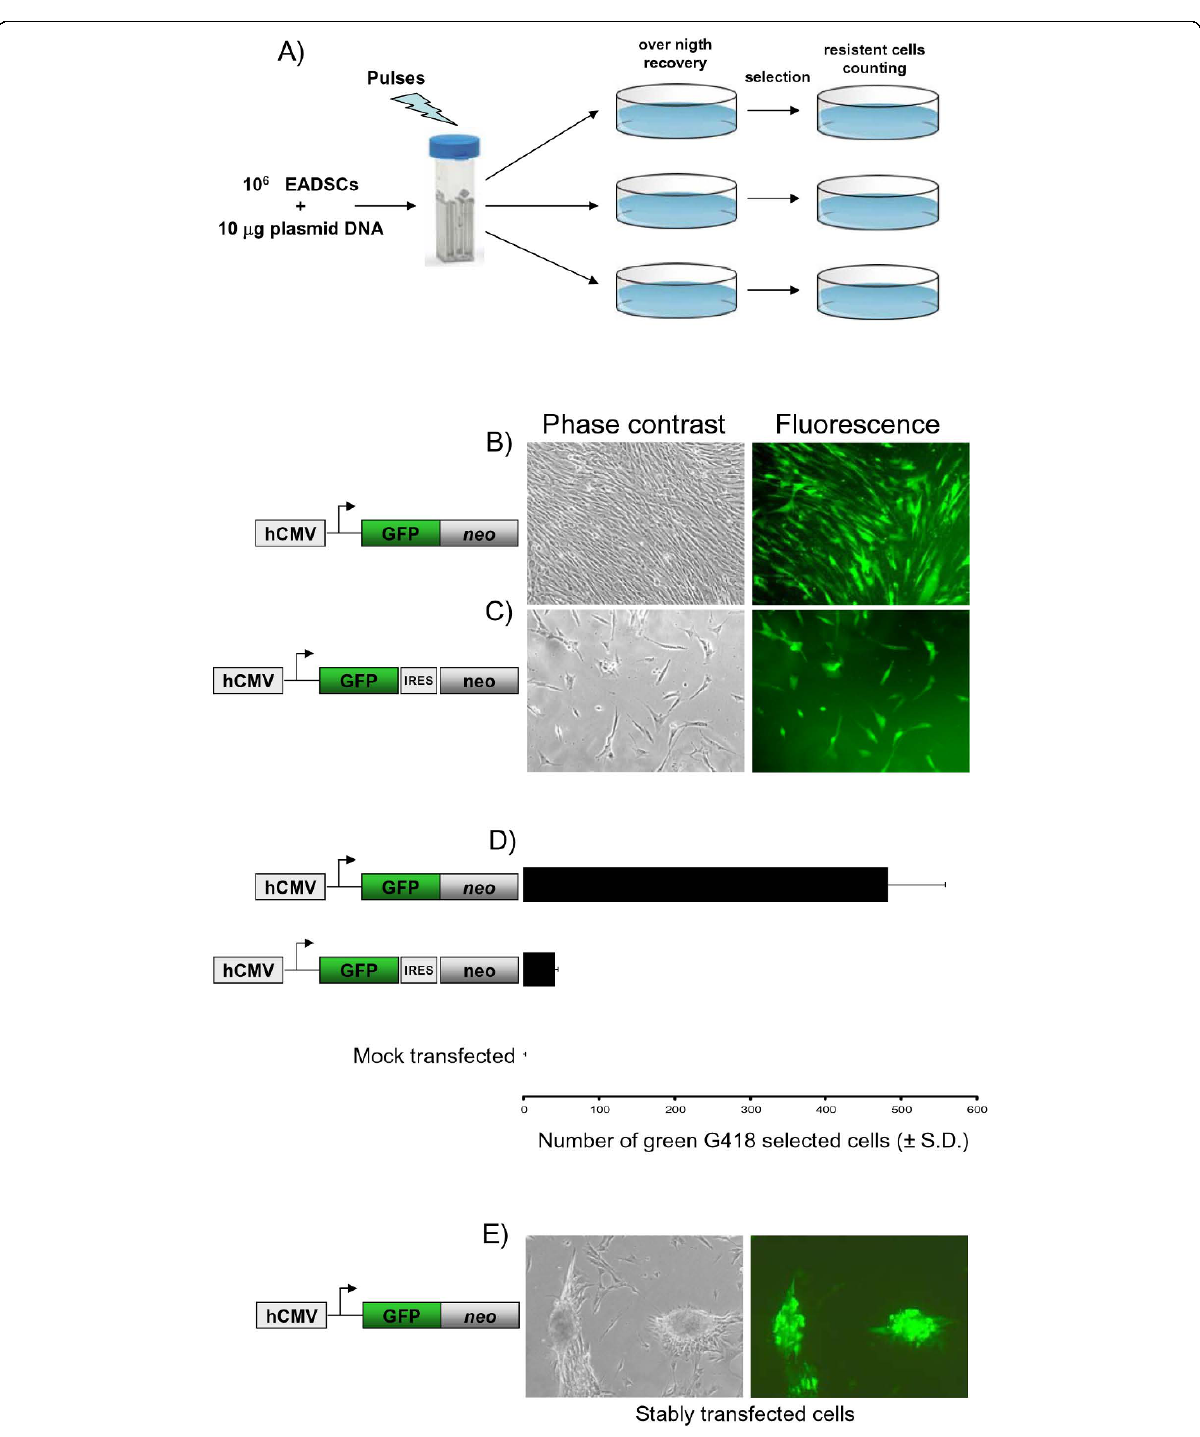
Figure 5 Generation of stably transfected EADSCs . A) Flow chart of the method used to obtain a homogeneous population of EGFP stably labelled EADSCs by electroporation and drug selection. Phase contrast and fluorescence representative images (20×) of green G418-selected EADSCs generated with pCMV-EGFP/ neo fusion peptide (B) and pCMV-EGFP-IRES- neo bicistronic vector (C) (diagram not on scale beside the images). D) Generating efficiency of green G418 selected EADSCs obtained with pCMV-EGFP/ neo and pCMV-EGFP-IRES- neo respectively and compared to mock-transfected EADSCs. Each experiment was done in quadruplicate, and each point represents the average ± standard deviation from three experiments. Green G418 EADSCs were monitored by fluorescence microscope and quantified by flow cytometry. E) Phase contrast and fluorescence representative images of differentiated stable green G418 selected EADSCs obtained with pCMV-EGFP/ neo